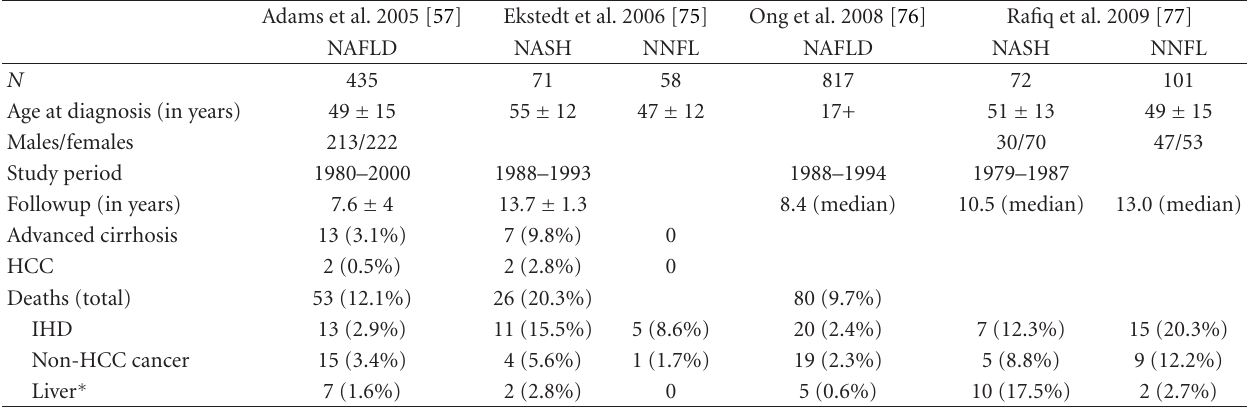
Table 2: Natural history data on